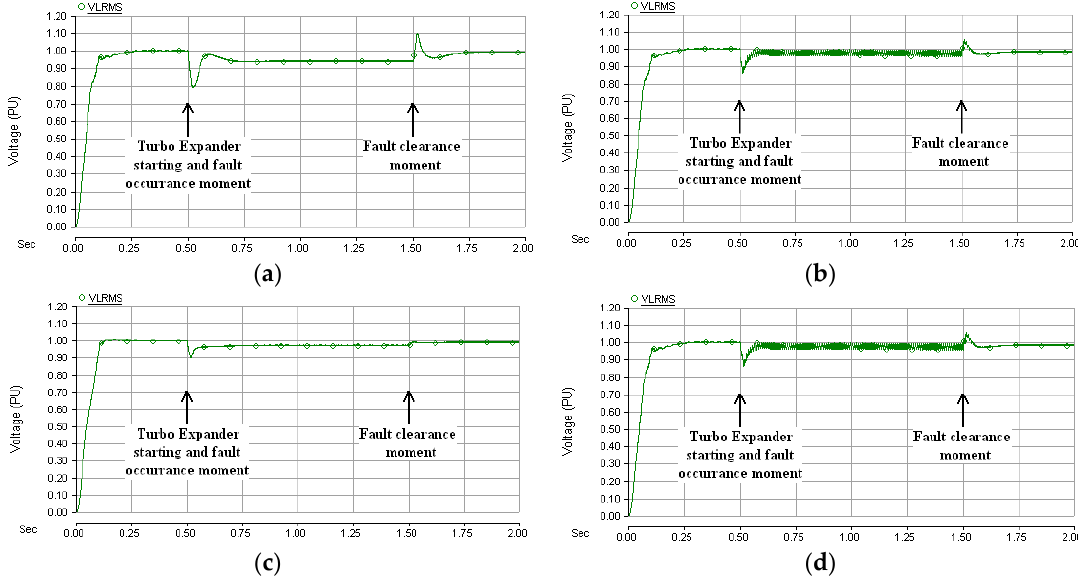
Figure 9. SATCOM performance at bus 2: ( a ) Scenario 13; ( b ) Scenario 14; ( c ) Scenario 15; and ( d ) Scenario 16.